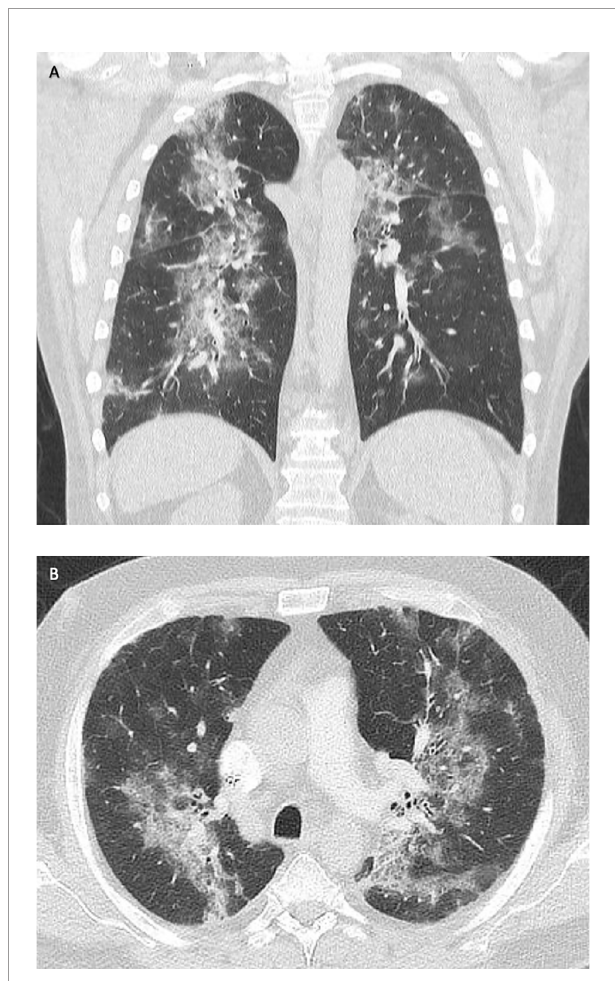
FIGURE 2 | Computed tomography (CT) of the lungs in frontal (A) and transverse sections (B) . Disseminated ground-glass opacities due to COVID-19 pneumonia (December